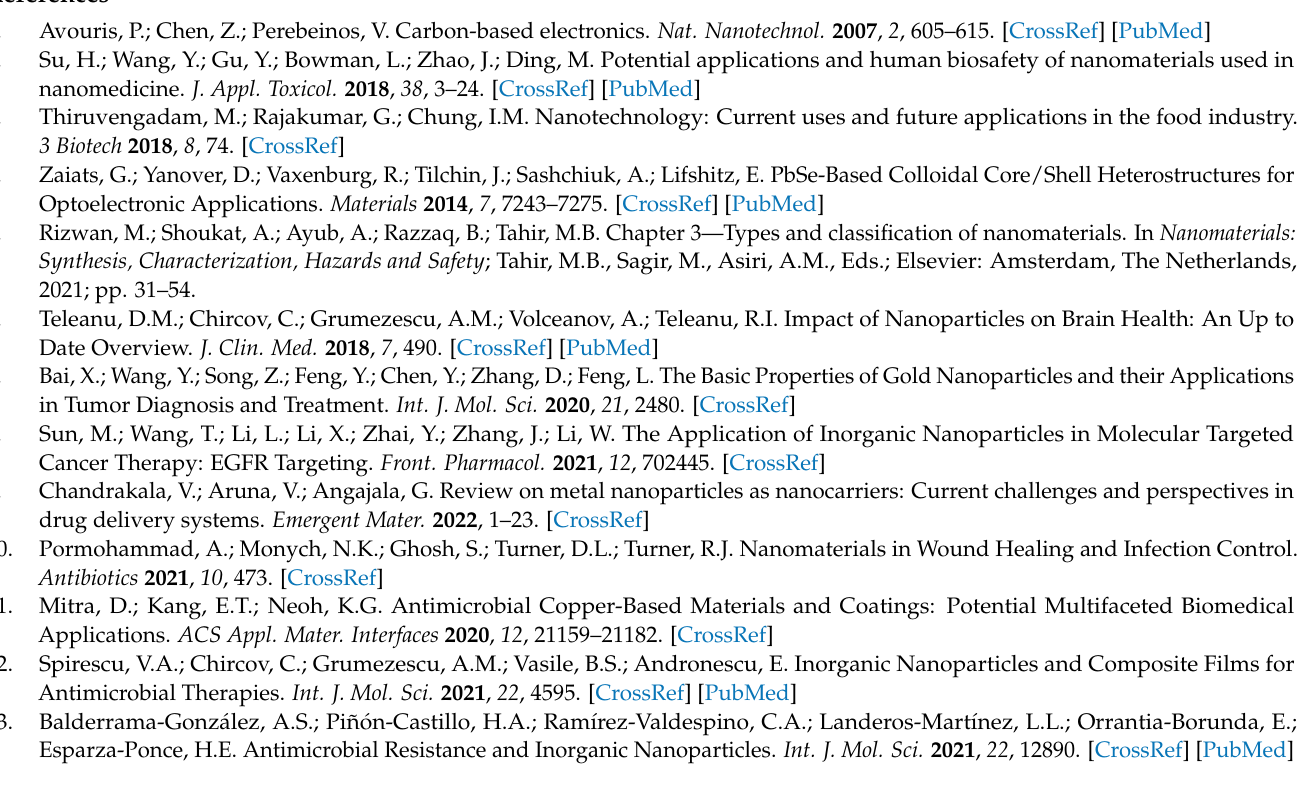
Figure S2: Cytotoxicity of 20 and 60 nm CuNPs in mammalian cells; Figure S3: Sequence alignment of modulator active domains in E. coli